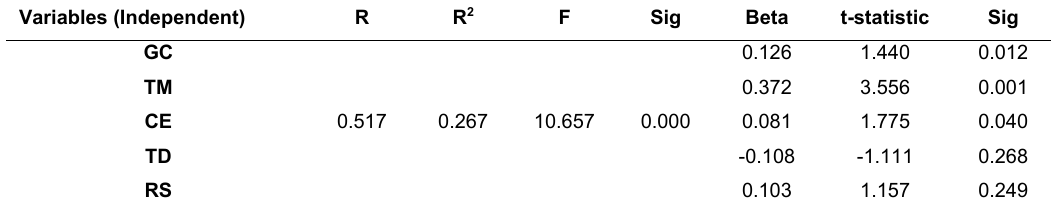
Table 10. Hypothesis test (H 3 ): Dependent variable: Normative